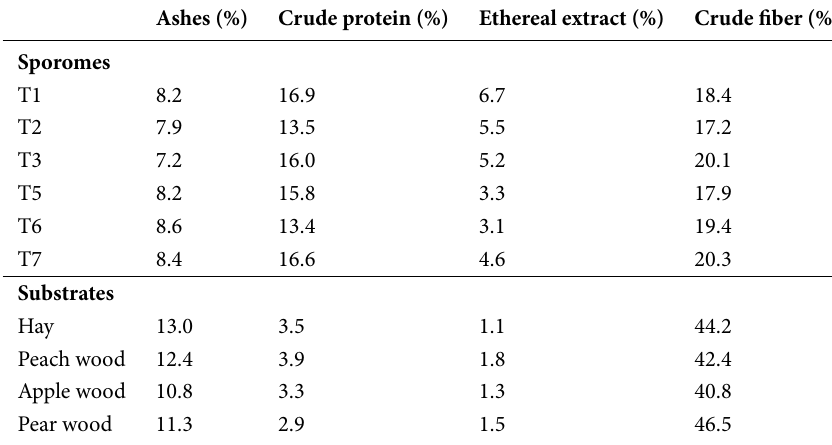
Table 1 Bromatological analysis of Pleurotus ostreatus from different substrates and analysis of pure